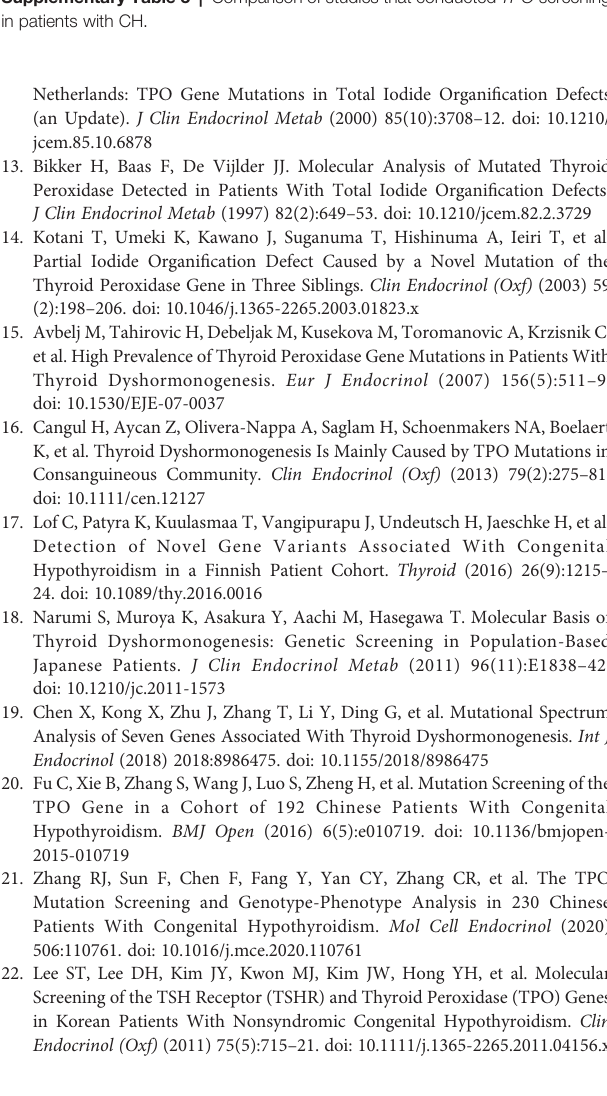
Supplementary Figure 1 | Computer generated models of the wild type and mutant TPO. Ribbon (A, C, E, G) and Stick (B, D, F, H) presentation of wild-type and mutant TPO proteins [ (A, B) p.Asn798Arg; (C, D) p.Arg769Trp; (E, F) p.Asn592Ser; (G , H) p.Ala443Val]. These four selected residues as well as those that have an interaction with them are shown as sticks. Non-covalent interactions are shown as dashed lines. Supplementary Figure 2 | Comparisons of the amino acid sequences neighboring the mutations among different species, and different members of peroxidase superfamilies. Supplementary Table 1 | Classi fi cation and evidence of detected TPO variants. Supplementary Table 2 | In silico prediction of the function of detected TPO variants. Supplementary Table 3 | Comparison of studies that conducted TPO screening in patients with